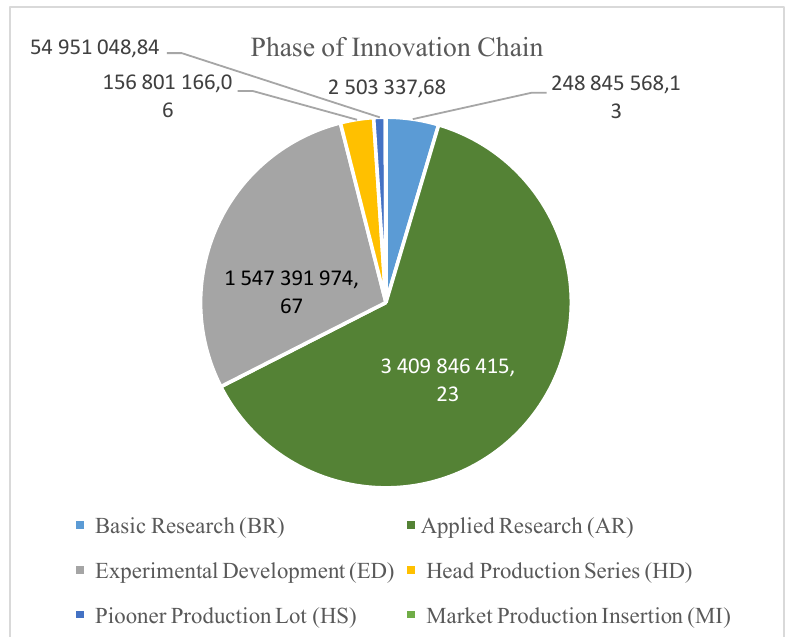
Fig. 3. Phase of Innovation Chain (ANEEL, march 2015).